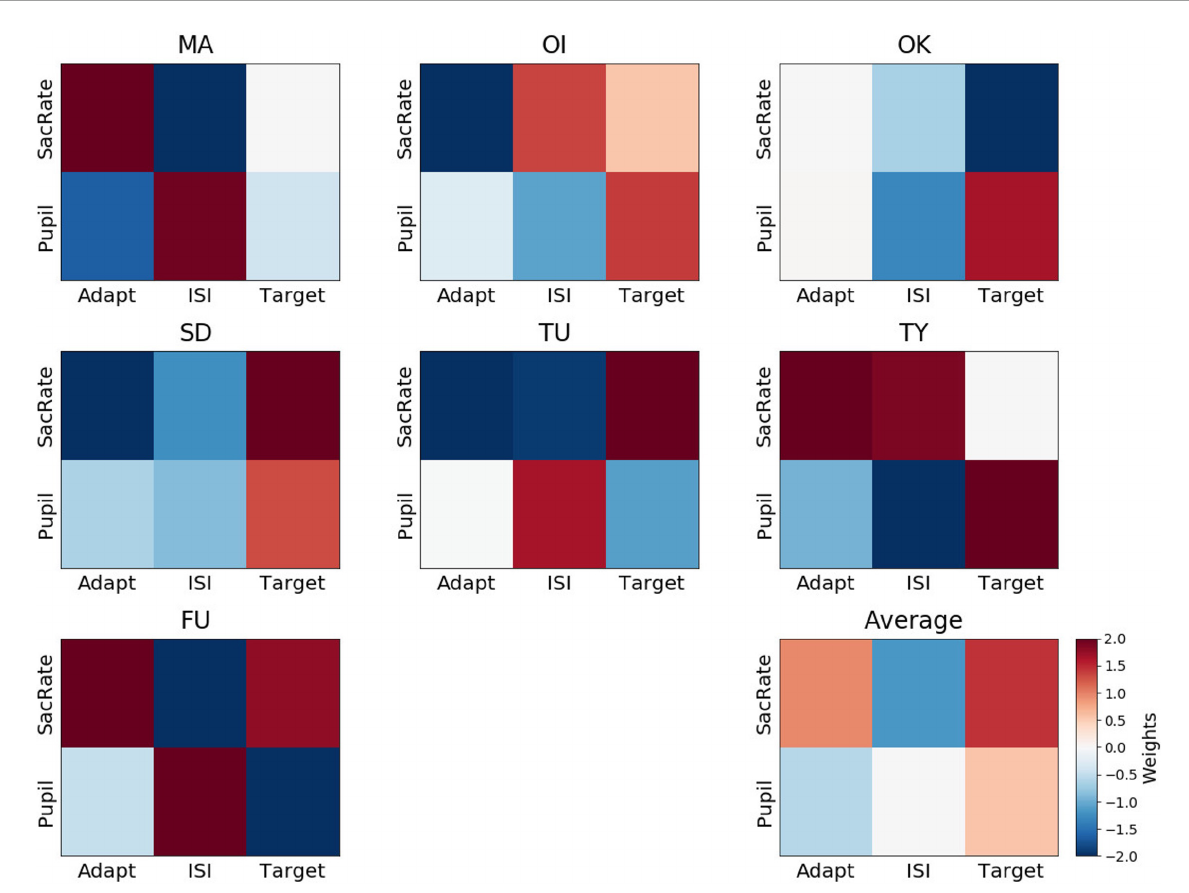
FIGURE5 Weights assigned by the perceptual-decision decoder. Representation of decoder weights from every participant attributed to the mean microsaccade rate (SacRate) and the mean pupil size (Pupil) during the adaptation (Adapt), inter-stimulus interval (ISI), and target (Target) periods, respectively. For visualization purposes, the color scale was bounded between – 2 and 2, but some weights were outside this range.